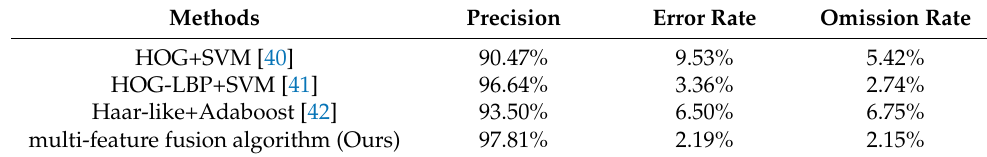
Table 1. Detection performance under good weather conditions (five-fold crossvalidation set).